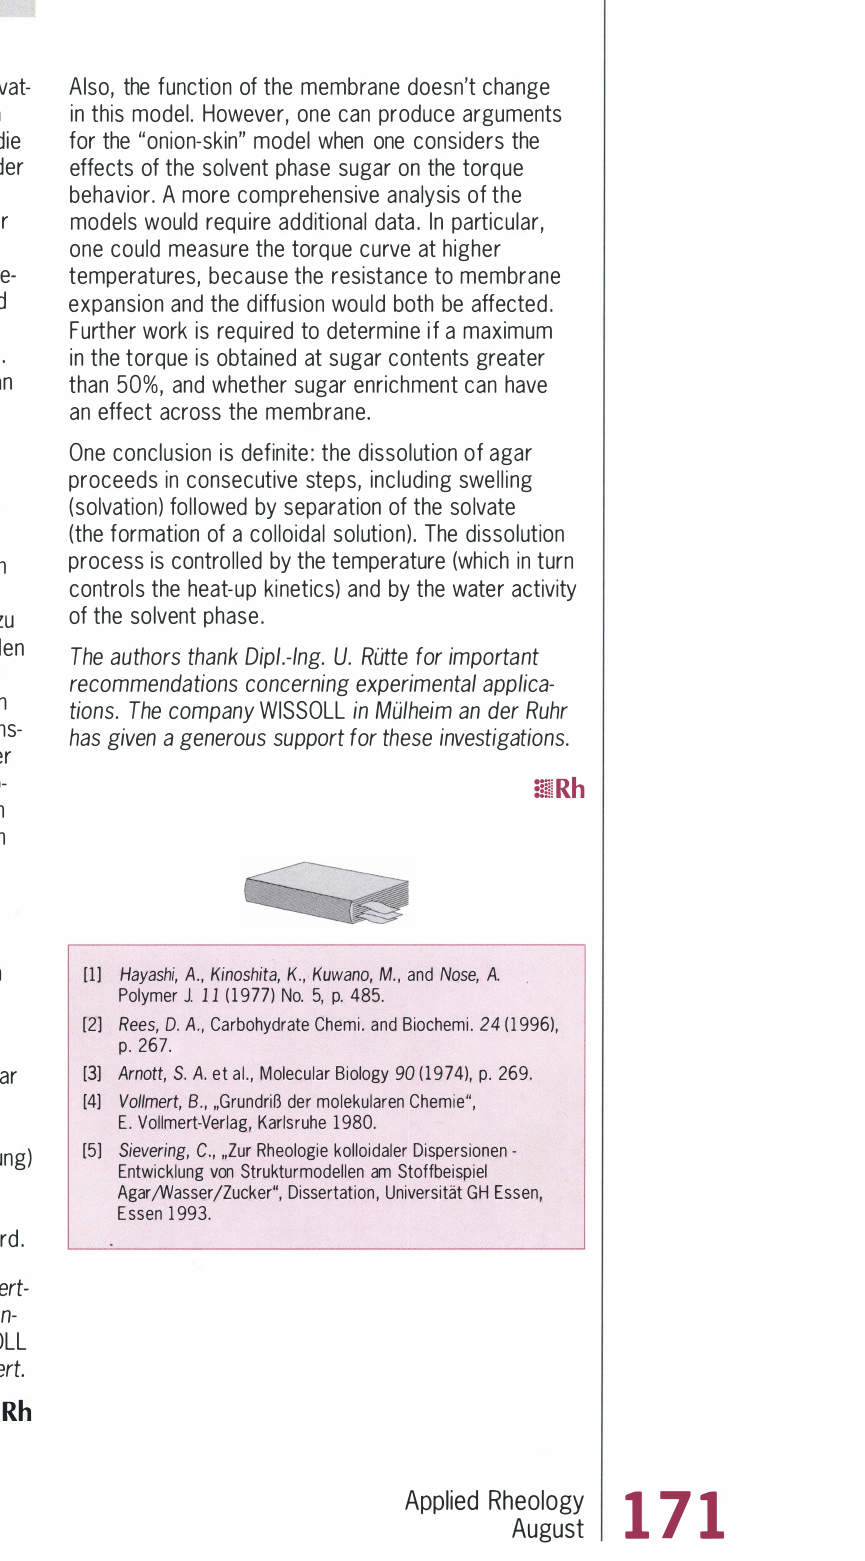
Fig. 5 Swelling and dissolution of agar in saccharose solution M,., -torque for the agarsuspension devided by the torque for pure solution T -temperature To% -heat-up kinetic for pure water T60 % - heat-up kinetic for a 60%saccharose